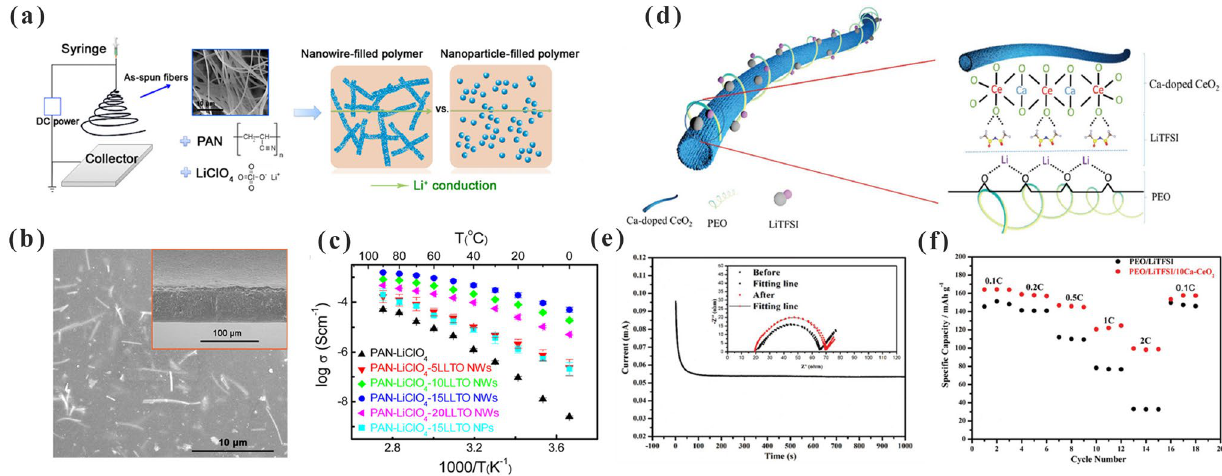
Fig. 4 a Lithium-ion pathways in nanowire- and nanoparticle-filled PAN CPEs; b SEM pictures for the PAN-LLTO NWs; c Arrhenius plots of the PAN-LLTO NWs and PAN-LLTO NPs CPEs. Adapted with permission from Ref. [105]. d Diagram of the enhanced mechanism of lithium- ion transport in Ca–CeO 2 -PEO CPEs; e Chronoamperometry curves of Ca–CeO 2 -PEO CPEs; f Rate performance of PEO-LiTFSI and Ca–CeO 2 - PEO CPEs with